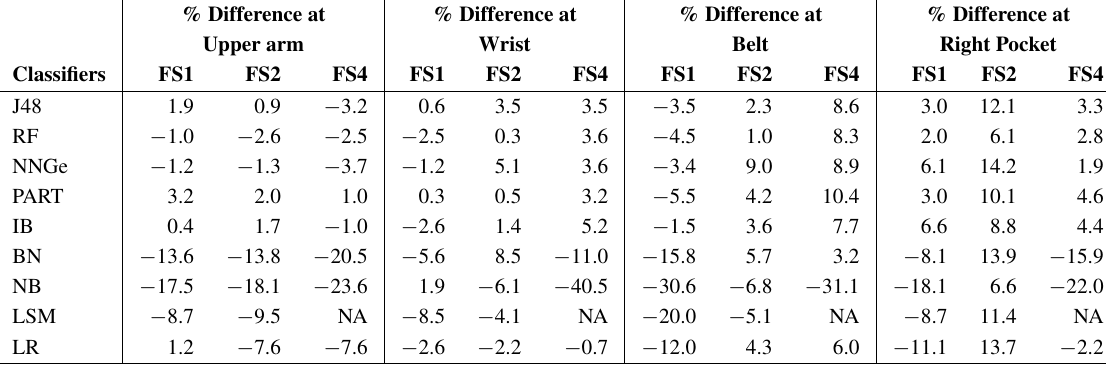
Table A.2. Performance difference (gyroscope (G)—accelerometer (A)) for the walking upstairs activity in Scenario A.